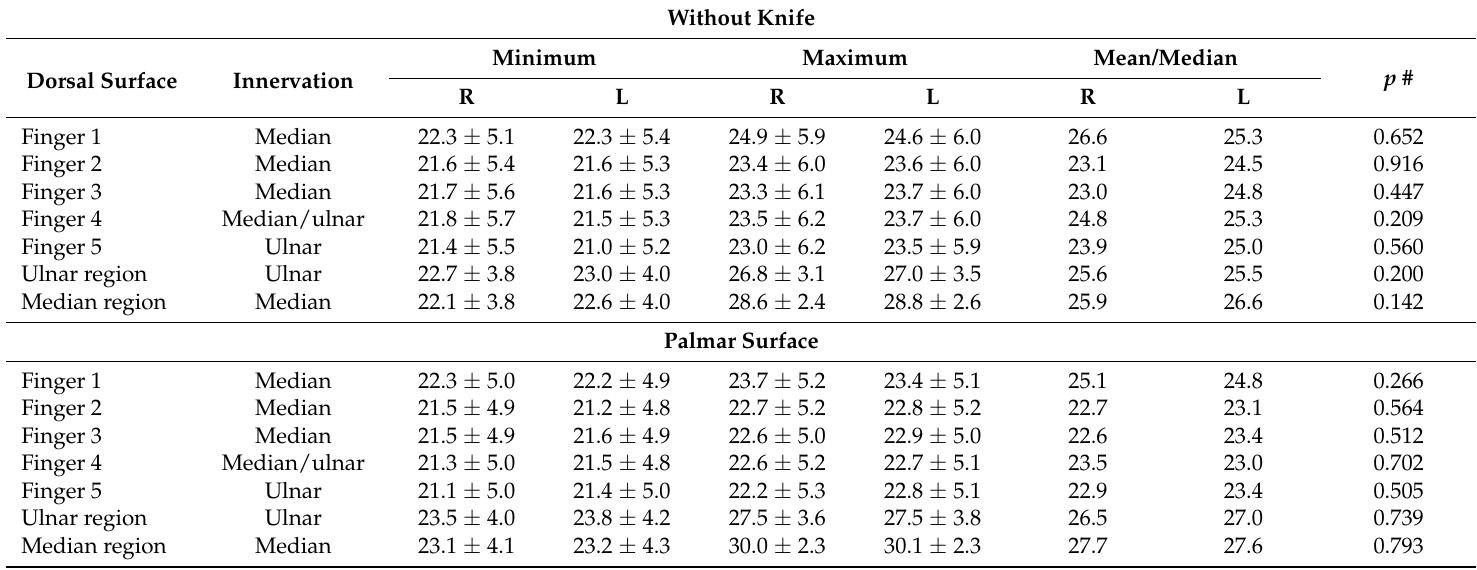
Table 1. Presentation of the temperature values ( ◦ C) of the analyzed body regions and the comparison between the mean or median temperature of the hands (right and left) as the use of the knife by